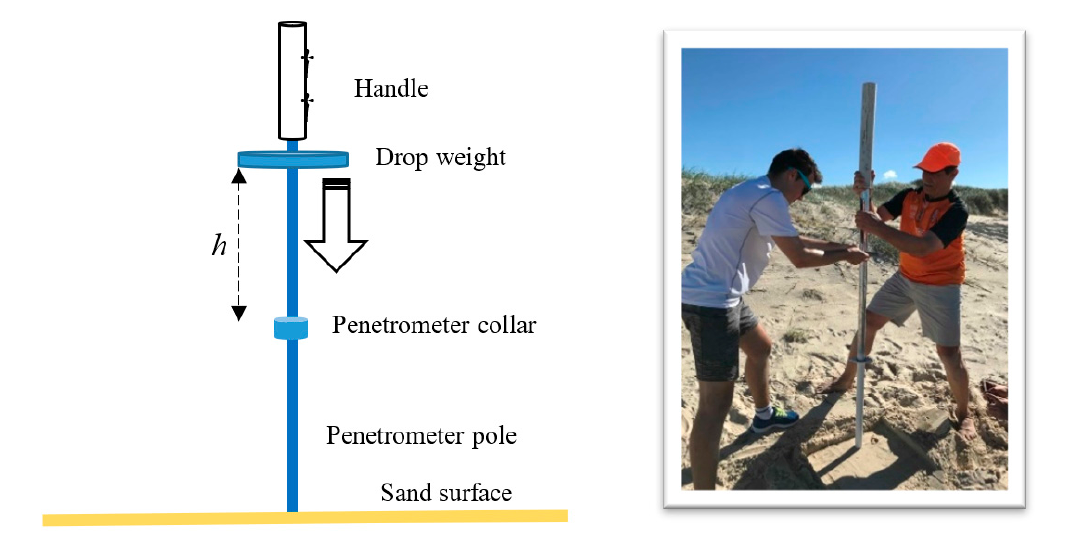
Figure 1. The experimental configuration. The drop weight was released from a predefined height h and the penetration depth in the sand was measured. The handle was used to position the pole vertically with the assistance of a spirit